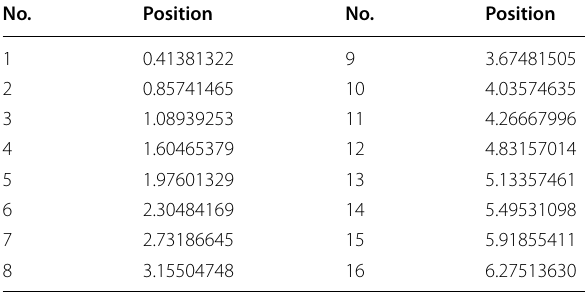
Table 3 A random mistuned bolt distribution with the standard deviation σ θ 10% = No.